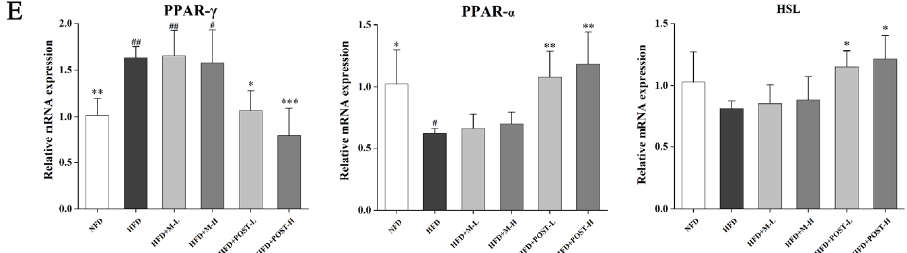
Figure 1. POST ameliorated obesity in HFD mice. ( A ) Weight change over 12 weeks. ( B ) Total weight gain. ( C ) The e-WAT index. ( D ) H&E staining of e-WAT (magnification 200 × ). ( E ) Relative mRNA expression of PPAR- γ , PPAR- α , HSL in the e-WAT. Compared to HFD, * p < 0.05, ** p < 0.01, and *** p < 0.001; Compared to NFD, # p < 0.05, ## p < 0.01, and ### p < 0.001.